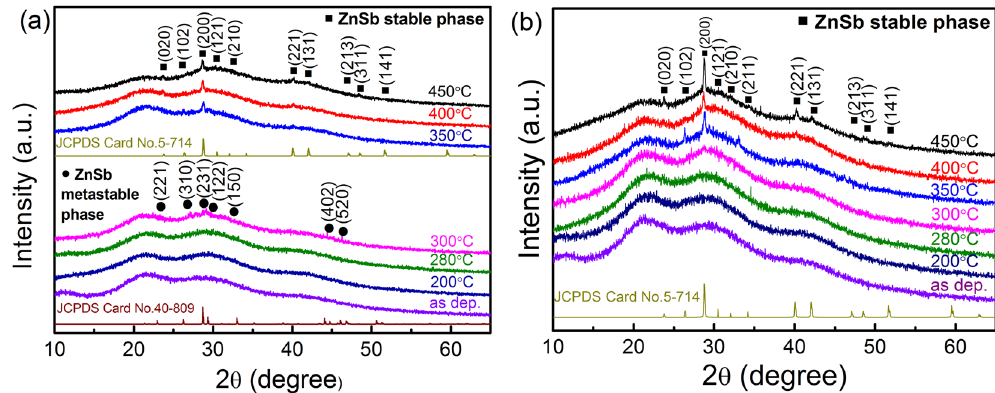
Figure 1. XRD patterns of as-deposited and annealed ( a ) undoped and ( b ) NiO-doped ZnSb films. At the bottom are shown the peak positions and intensity taken from metastable and stable ZnSb phase in the XRD database for